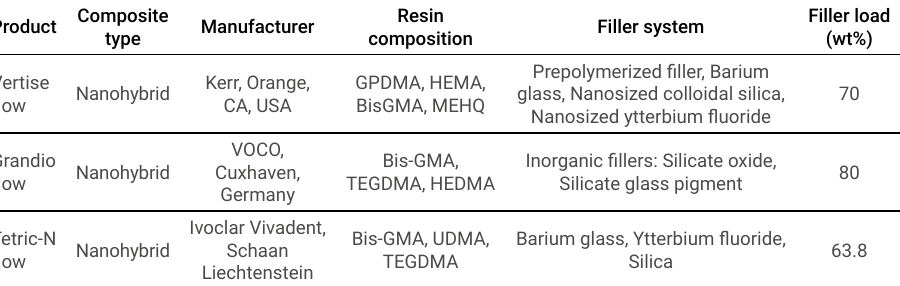
Table 1. Resin composites used and their classification, manufacturer, and composition Composite Product